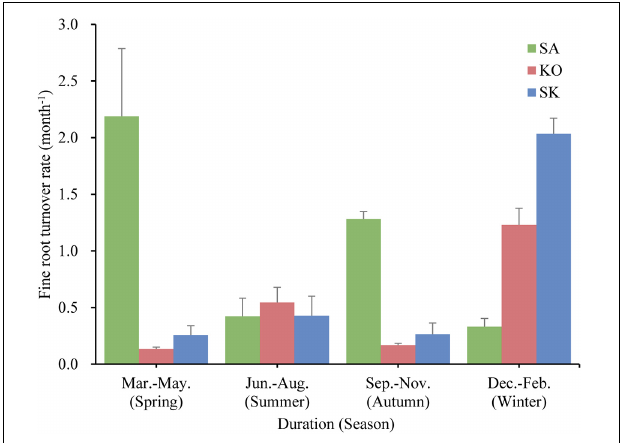
FIGURE 6 | Fine root turnover rate (month - 1 ) for S. apetala (SA), K. obovata (KO) monocultures and the mixed (SK) plantations in different seasons over a year at Hanjiang River Estuary, south